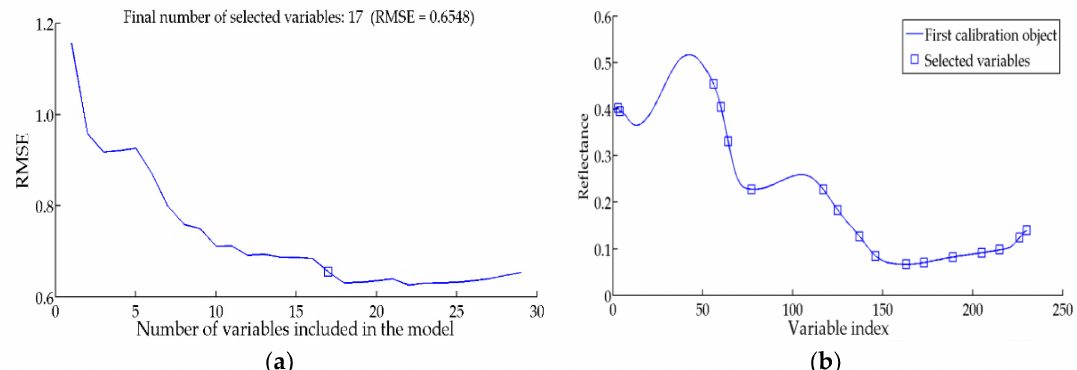
Figure 5. Characteristic wavelengths selection results of SPA: ( a ) Distribution of RMSE; ( b ) Distribu- tion of the selected 17 variables.